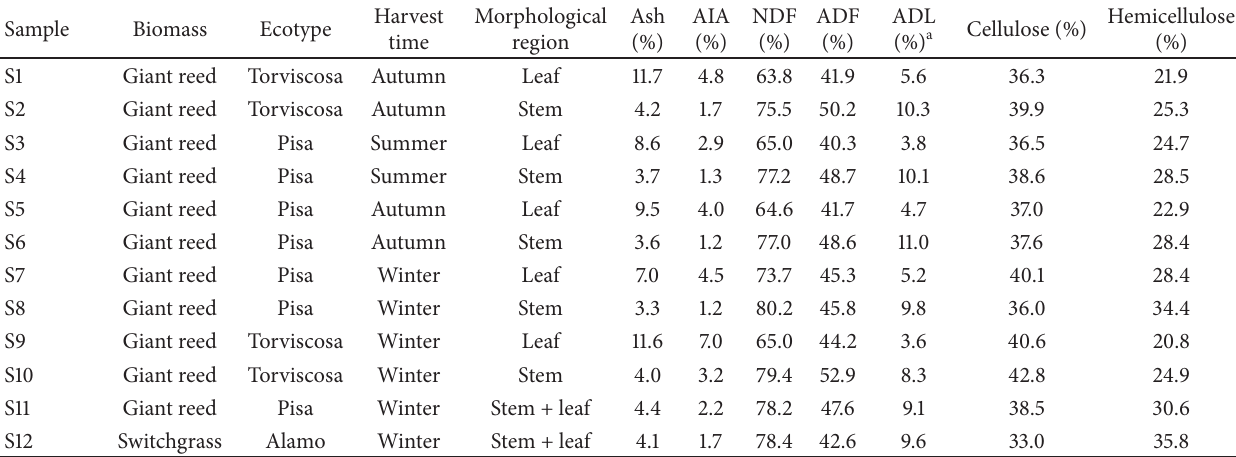
Table 3: Results of characteristic parameters obtained with Van Soest analysis for giant reed (S1–S11) and switchgrass samples (S12) and relative cellulose and hemicellulose %